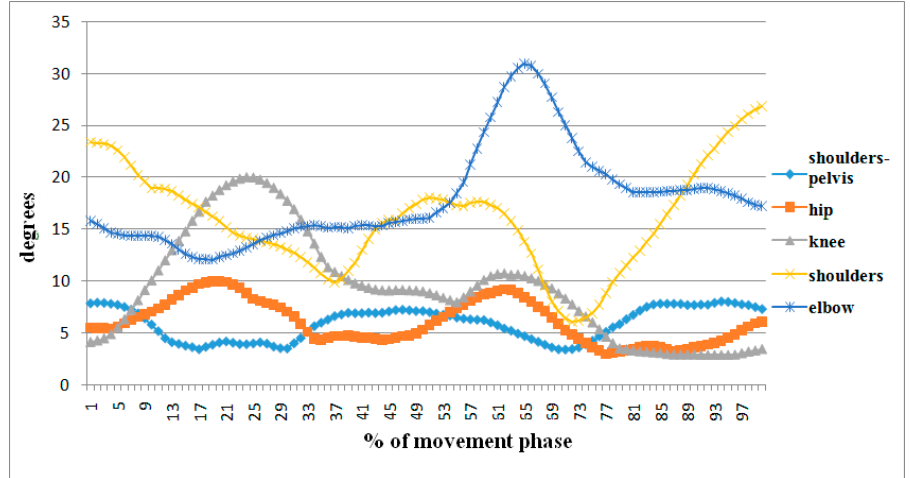
Figure 6. Variation values (average absolute deviation) for each goniogram in the format of a motion cycle.